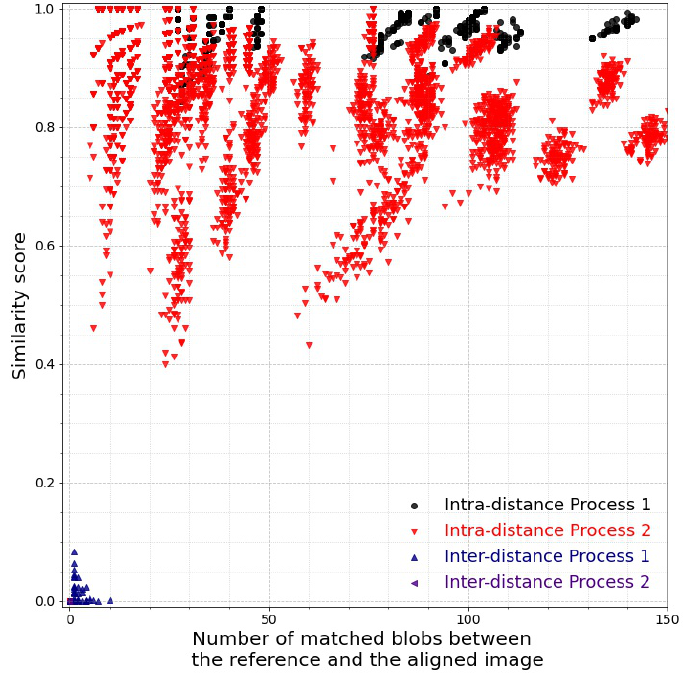
Figure 9. Clustering, and intra-distance and the inter-distance results while comparing images in Laboratory (Process 1) and Realistic data sets (Process